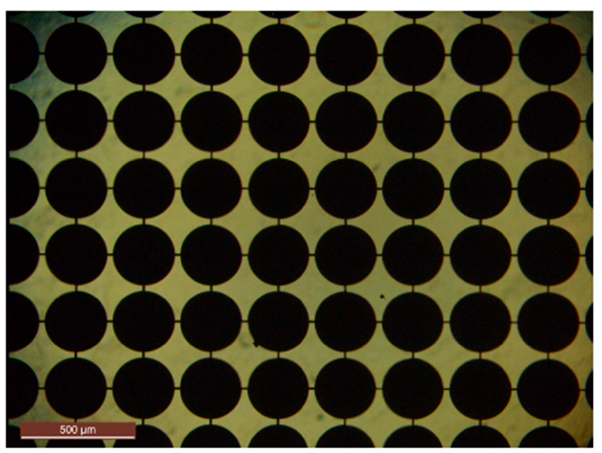
Figure 1. Fabricated patch array.